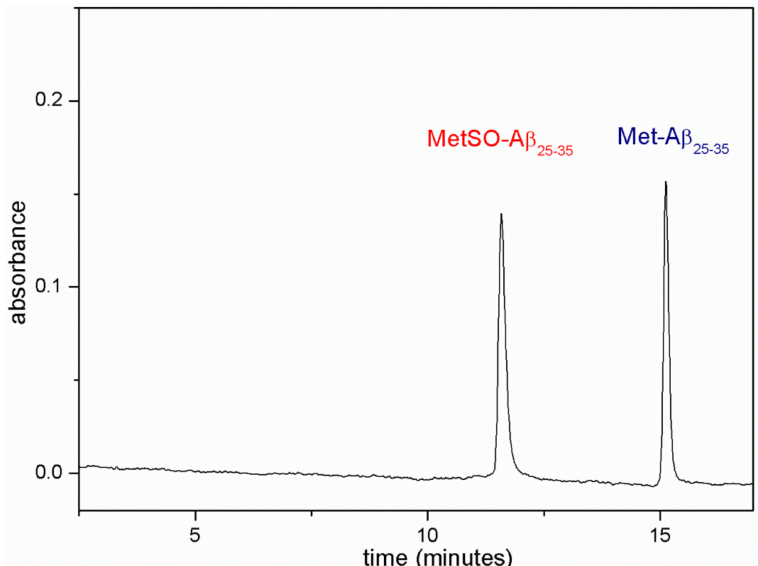
Figure 1. HPLC profile of A β 25-35 incubated for 120 min with peroxymonocarbonate (PMC or HCO 4 − ) . 10 µ M A β 25-35 was allowed to react with peroxymonocarbonate at 0.8 mM final concentration in 0.1 M phosphate bu ff er, pH 7.4, containing 0.1 mM DTPA. After 120 min at room temperature, aliquots of incubation mixture were analyzed by